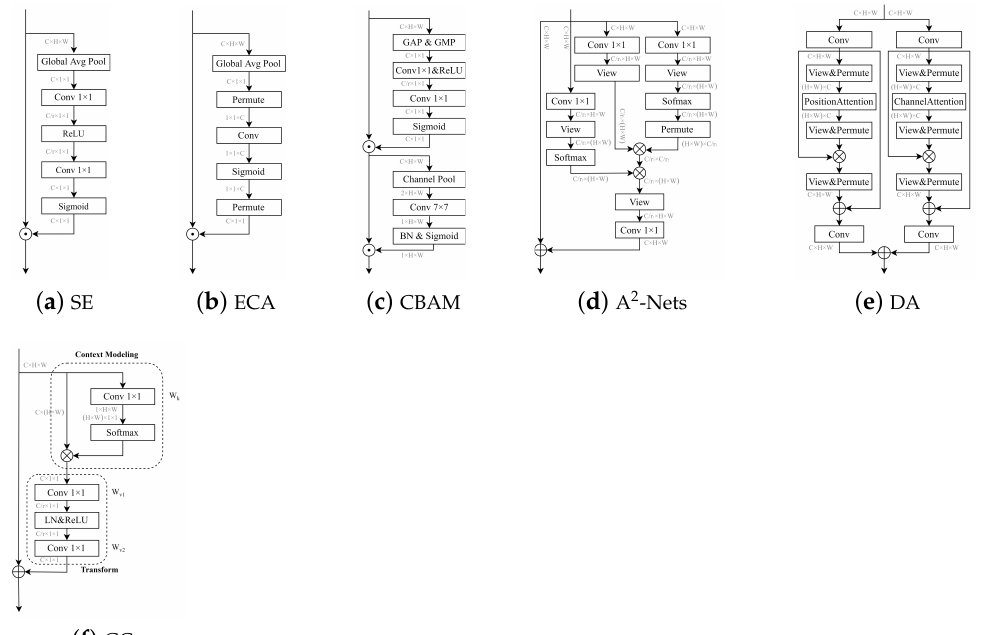
Figure 2. This diagram illustrates the framework of a model for three main forms of soft attention processes. Sub-figures ( a , b ) represent channel attention, ( c , d ) represent spatial attention, while ( e , f ) represent